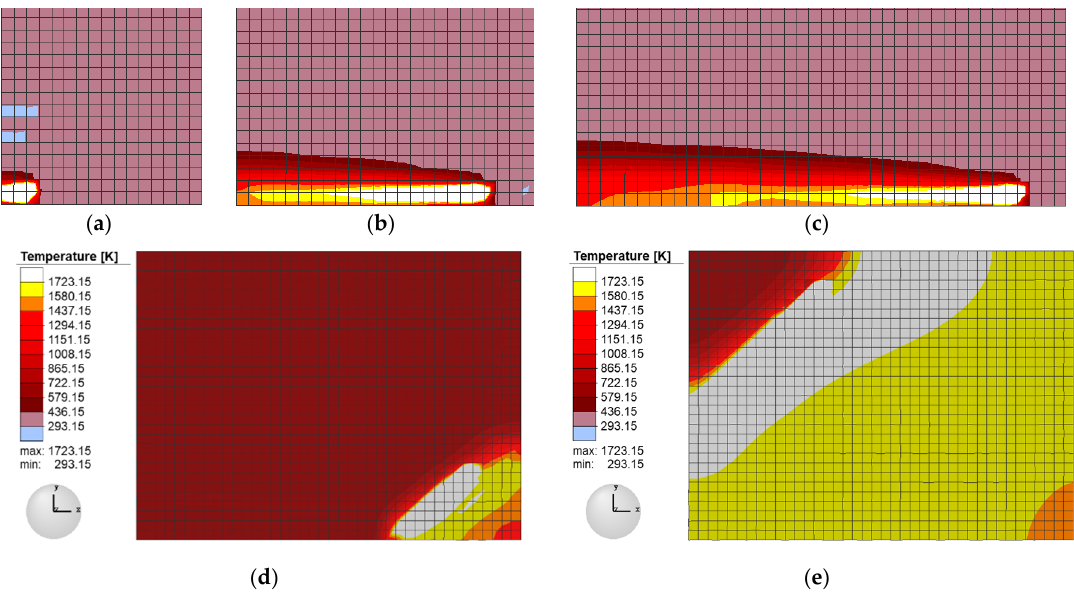
Figure 6. The laser heat source grows along the scanning trajectory at ( a ) 0.2 mm; ( b ) 2 mm; ( c ) 3 mm; ( d ) multitrack; and ( e ) multilayer.